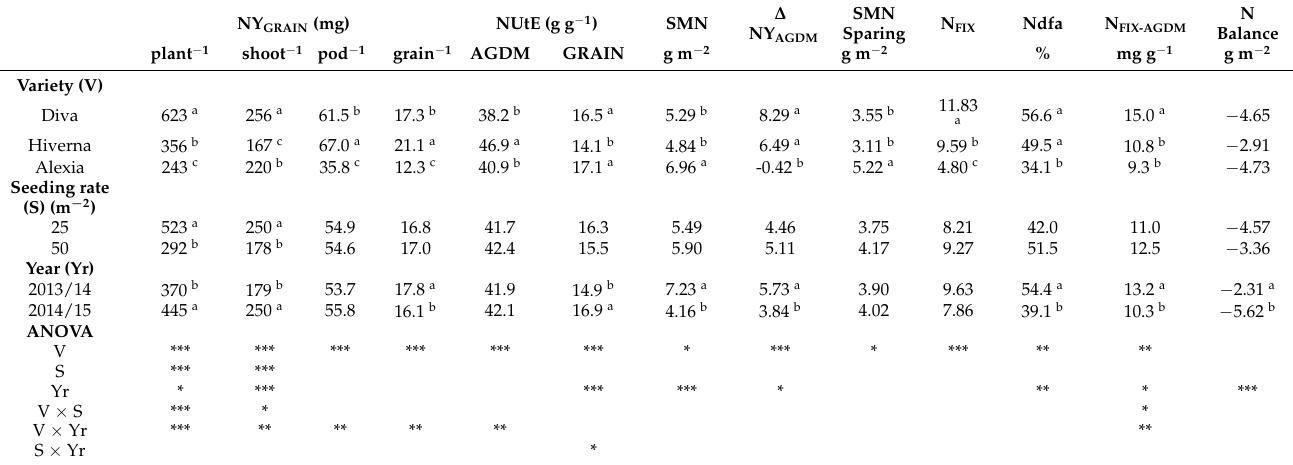
Table 2. Yields on the single plant level, nitrogen utilization, soil mineral nitrogen, nitrogen fixation and nitrogen balance of faba bean as affected by variety, seeding rate and year.